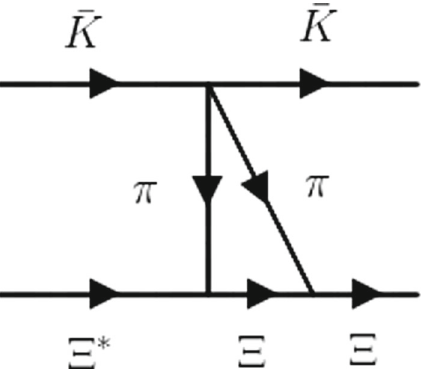
Fig. 4 Another possible d-wave diagram for the ¯ K (cid:3) ∗ → ¯ K (cid:3) transi- tion